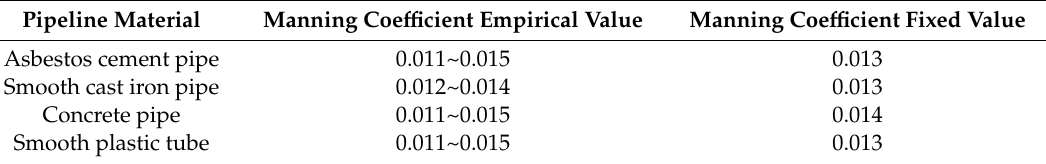
Table 4. Manning coe ffi cient of pressure